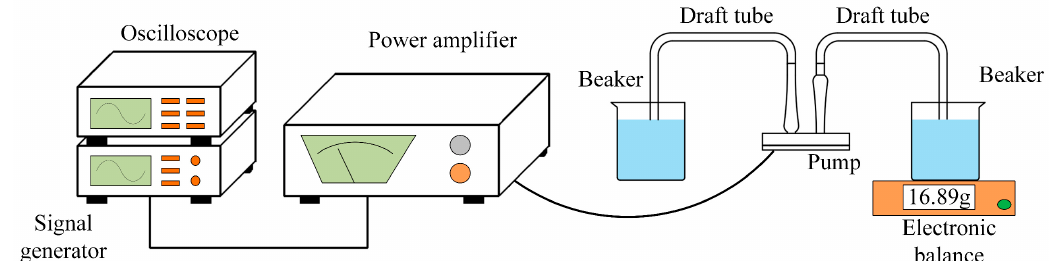
Figure 7. Schematic diagram of piezoelectric oscillator amplitude detection.